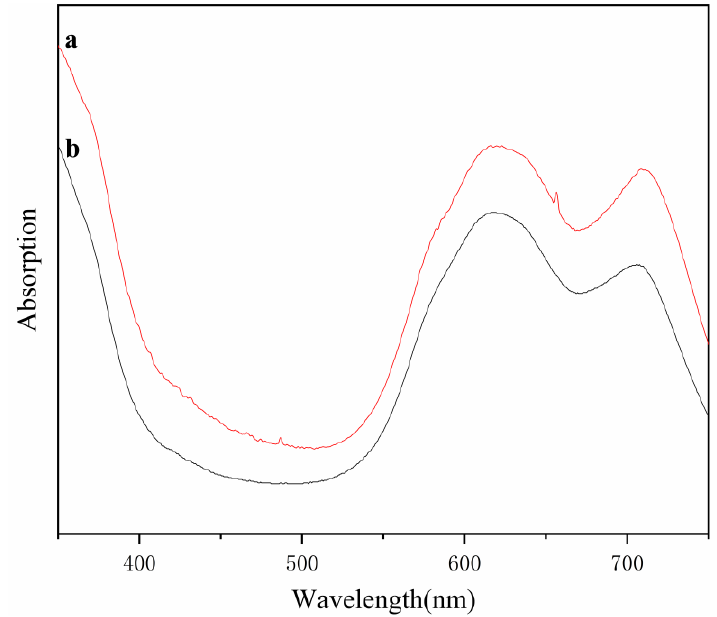
Figure 3. Absorption of visible light of unmodified pigments ( a ) and modified pigments ( b ).